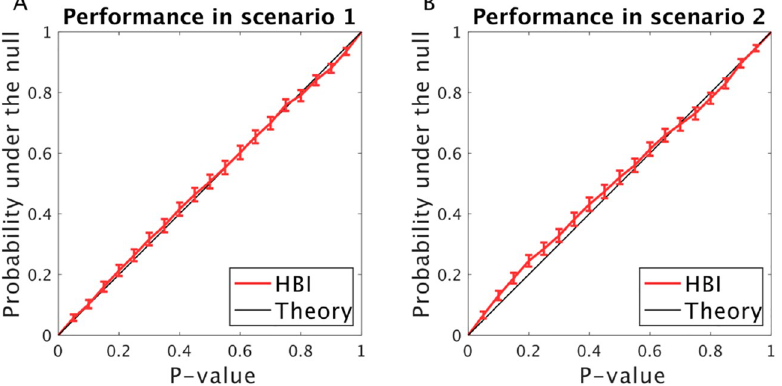
Fig 11. Performance of the HBI t-test under the null. A bias parameter was generated under the null (effect size is 0) in two simulations where A) there is only one model in the model-space (scenario 1); or B) there are two models in the model-space (scenario 2). The probability distribution of P-value is obtained by repeating the simulation 2000 times. Note that under the null hypothesis, the resulting P-value is theoretically expected to have a uniform distribution. The error-bars are 95% confidence intervals for the binomial